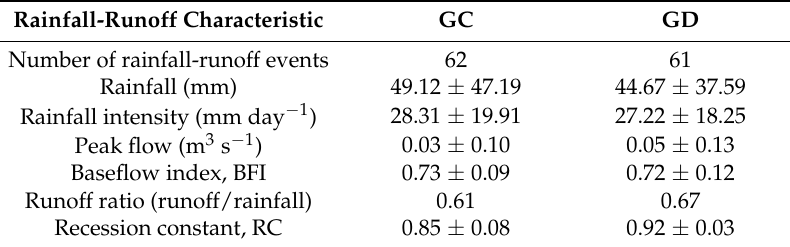
Table 2. Rainfall-runoff characteristics of the study sites (1982–2011).